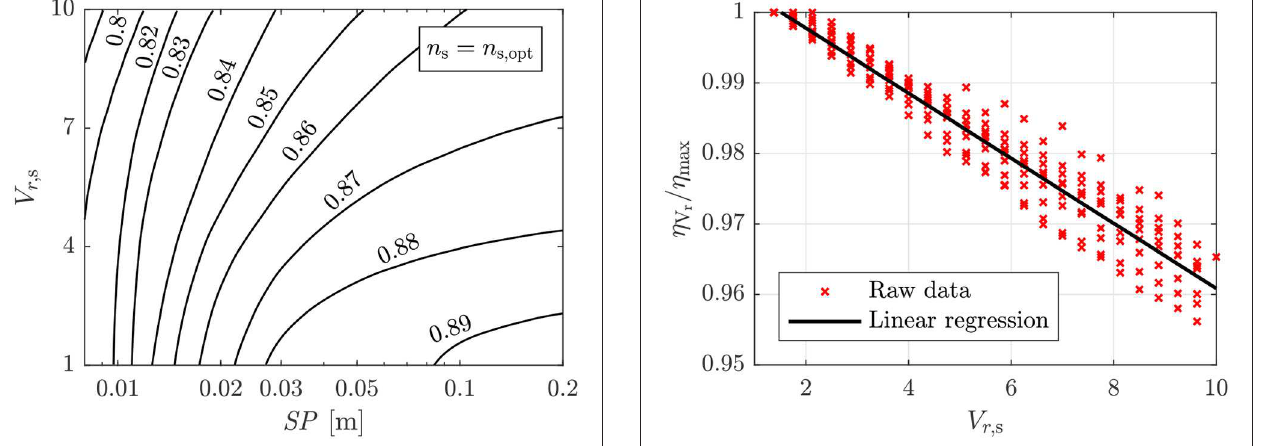
FIGURE 3 | Relationship between the isentropic volume ratio V r ,s and the normalized turbine efficiency. The red crosses correspond to data-points taken from Figure 2 and the black line corresponds to Equation